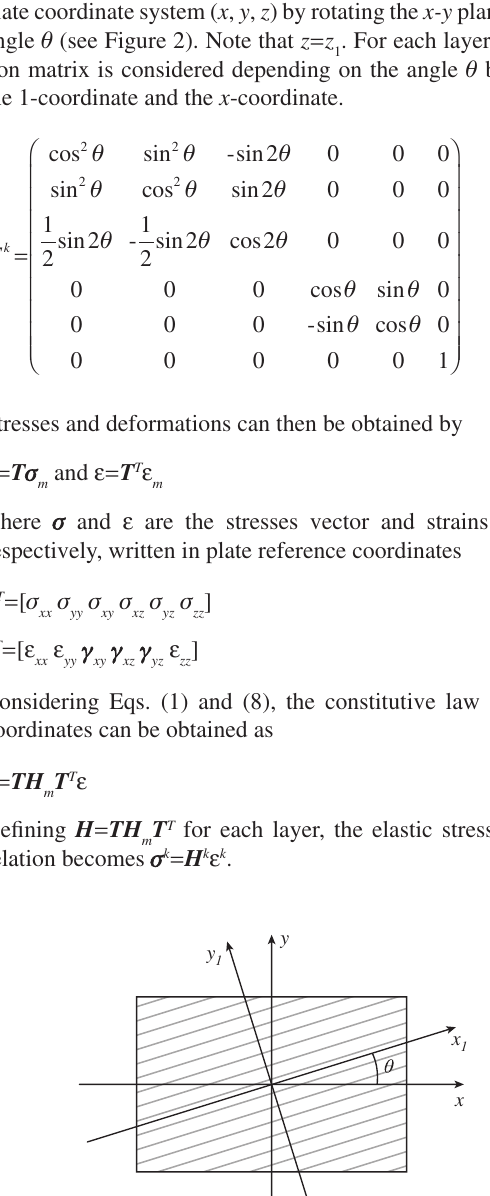
Figure 1 Rectangular plate subjected to compressive in-plane forces and distributed shear forces.